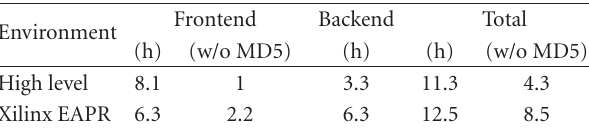
Table 7: Cryptographic application productivity